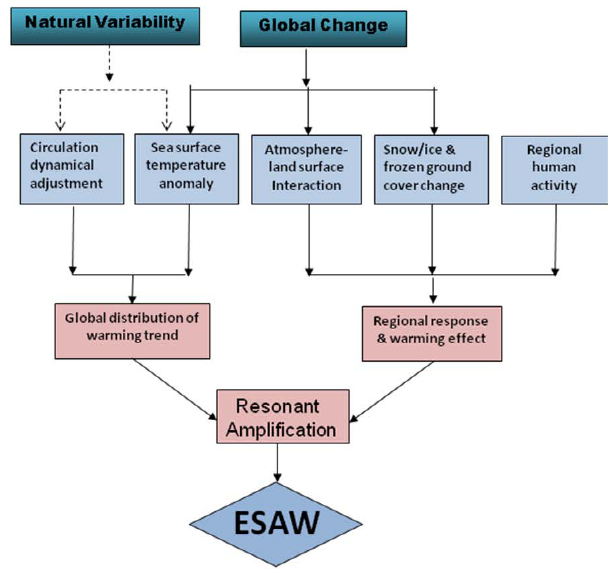
Fig. 9. Schematic diagram of enhanced semi-arid warming